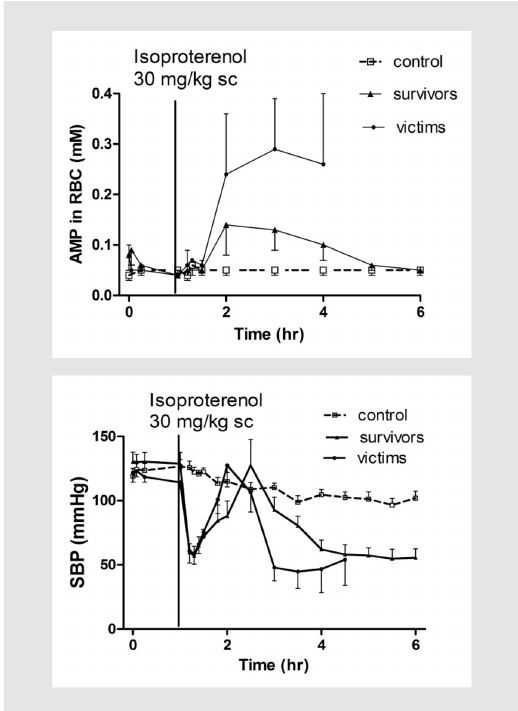
Figure 3. Effect of isoproterenol injection (30 mg/kg) on concentrations of AMP in RBCs and SBP. Each point represents mean ± SEM. Please note survivors were rats which survived from the experiment; victims died in less than 5–6 h after isoproterenol; and control did not receive